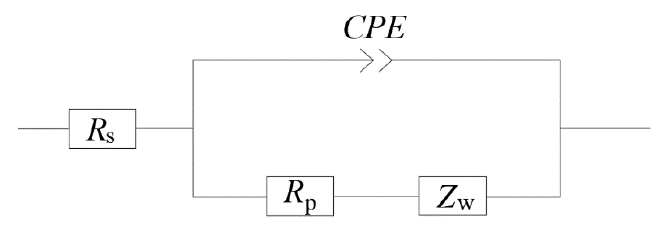
Figure 6. Equivalent circuit model of ionically conductive mortar.